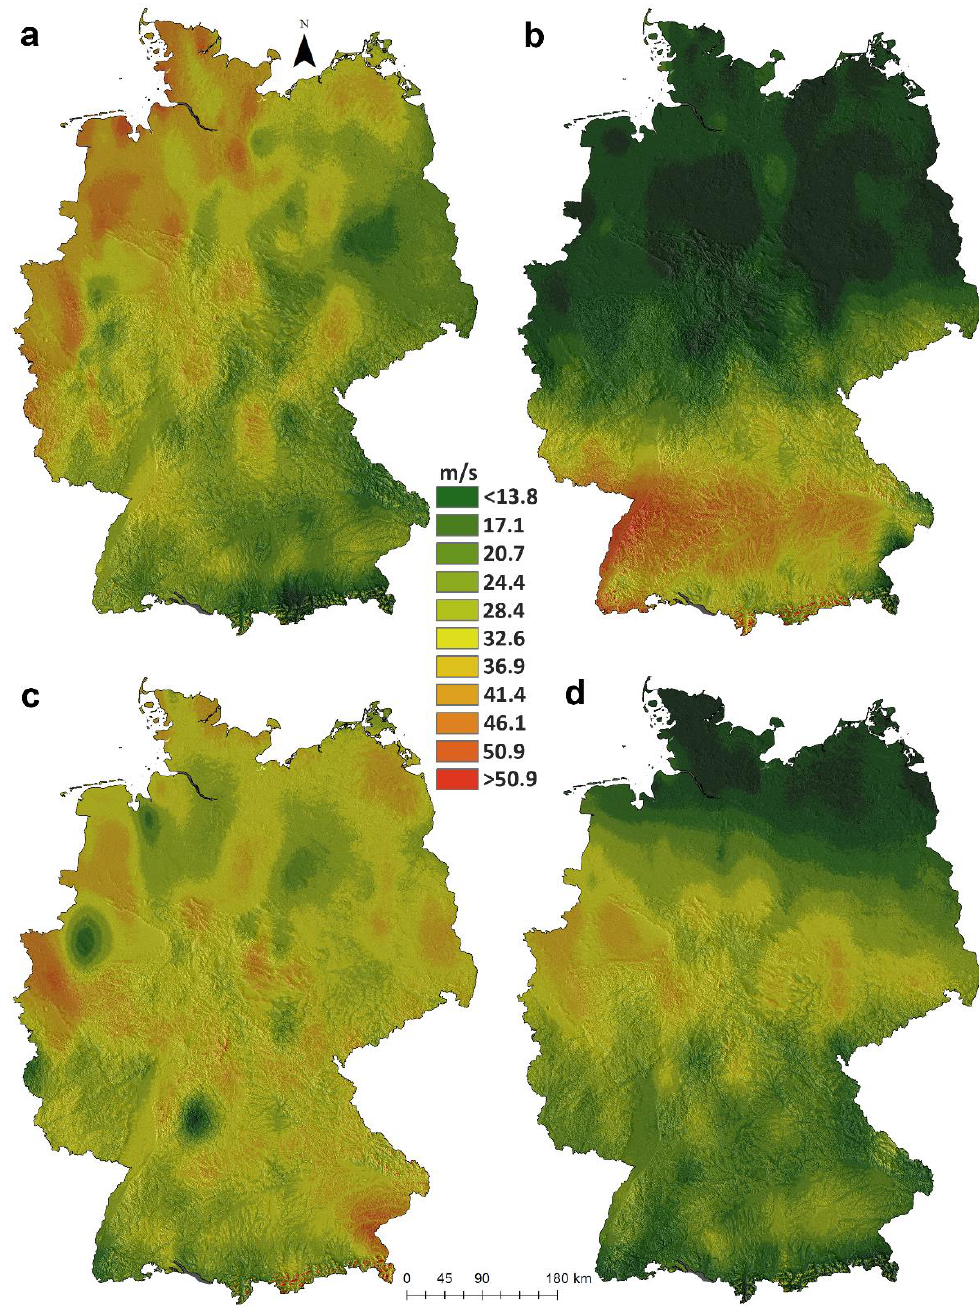
Figure 7. Gust speed ( GS ) fields of the winter storms ( a ) Daria; ( b ) Lothar; ( c ) Kyrill and ( d ) Friederike.